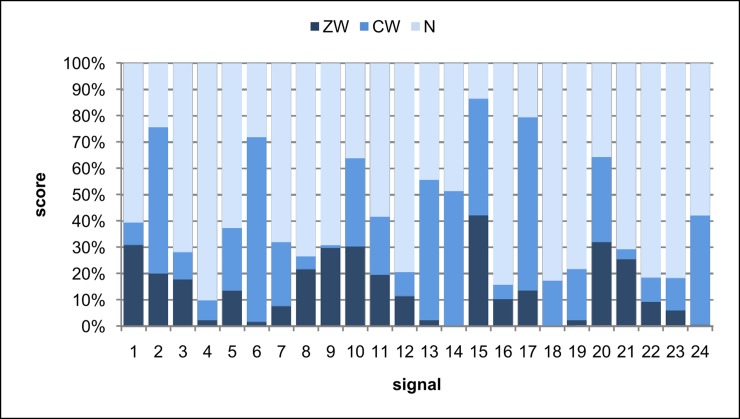
The distribution of answers that are in: full agreement with the “standard”(ZW), partial agreement with the “standard” (CW) and incorrect (N).